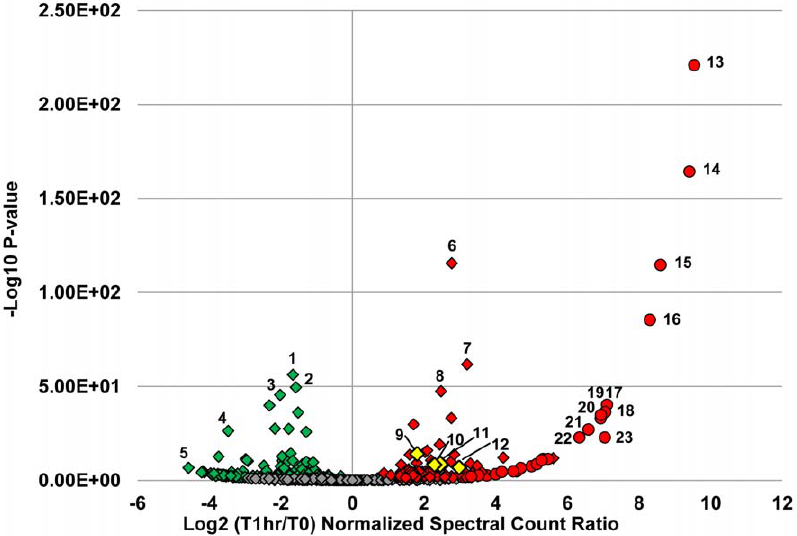
Figure 3. Volcano plot of protein abundance changes during peak infection at MOI=1. Normalized spectral counts were averaged between two technical replicates and the log 2 ratios taken between time 0 (pre-infection) and 1 hour post infection (peak infection). P-values were calculated using the exact Poisson test as described in the Materials and Methods section. The -log 10 of the P-values are plotted on the y-axis. Red color indicates an increase in abundance, green a decrease in abundance, and grey, no change. Diamonds represent host proteins: 1.) glyceraldehyde -3-phosphate dehydrogenase, 2.) pyruvate kinase, 3.) 3-phosphoglycerate kinase, 4.) ribosomal protein S9, 5.) ribosomal protein S8, 6.) ATP synthase, b subunit, 7.) ABC transporter, ATPase, 8.) RNA polymerase, b -subunit. Cas proteins are highlighted in yellow: 9.) Cas6e (CRISPR4), 10.) Cas7 (CRISPR4), 11.) Cas9 (CRISPR1), and 12.) Cas9 (CRISPR3). Phage proteins are depicted in circles: 13. and 14.) head proteins, 15.) scaffold protein, 16.) tail protein, 17.) terminase small subunit, 18.) portal protein, 19.-23.) phage proteins of unknown